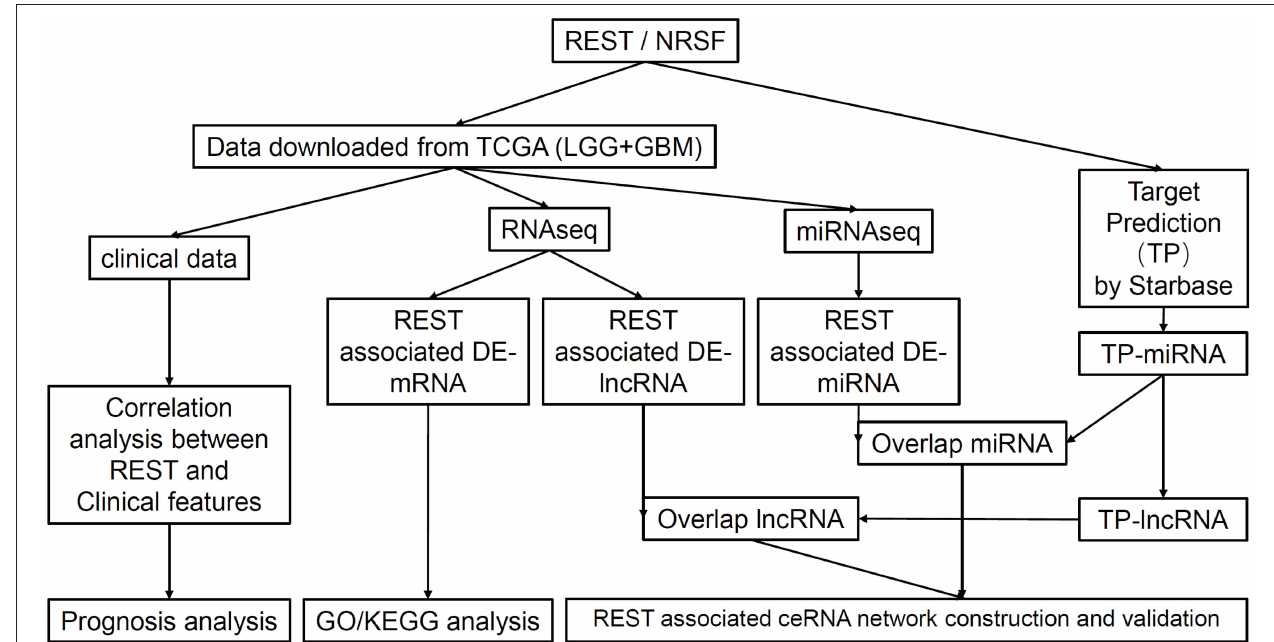
FIGURE 1 | Flow chart of the study.